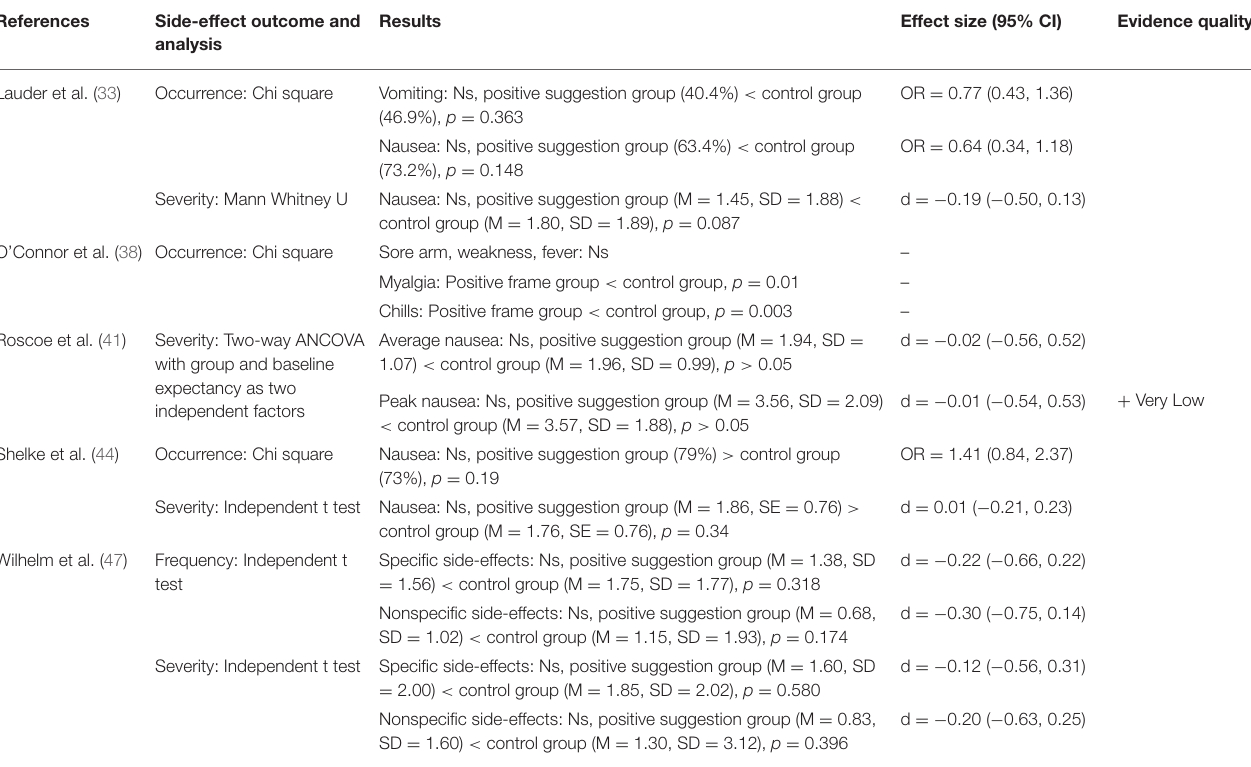
TABLE 6 | De-emphasizing side-effects intervention results.